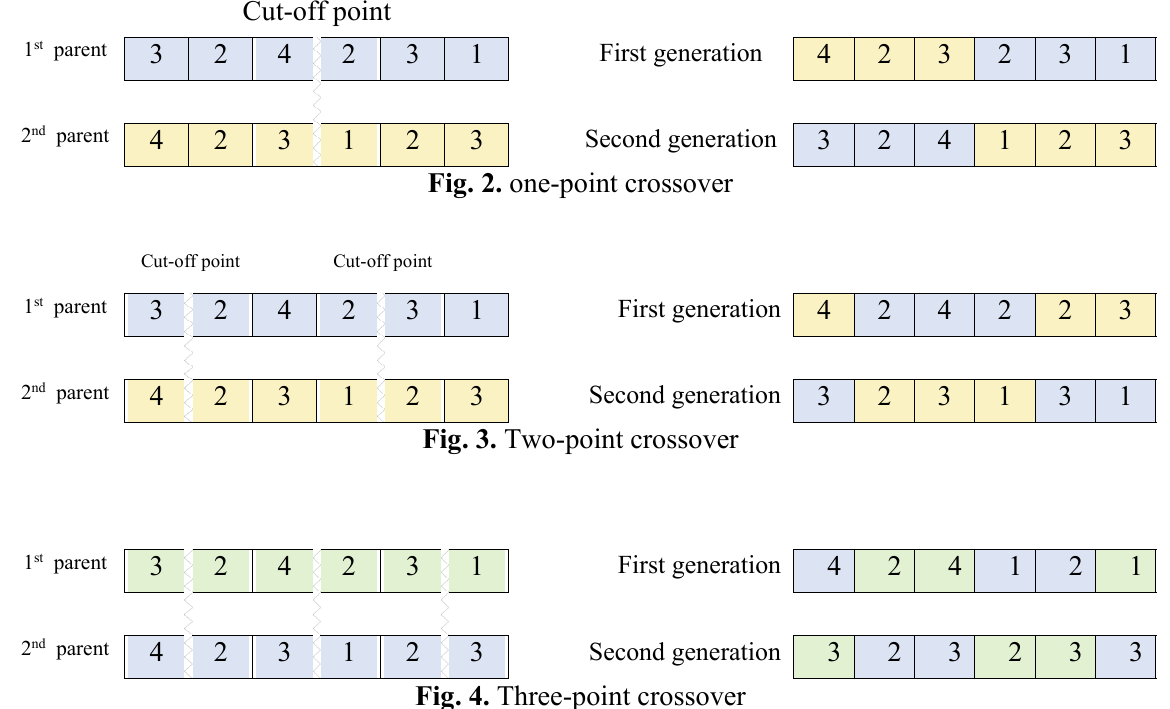
Fig. 4. Three-point crossover